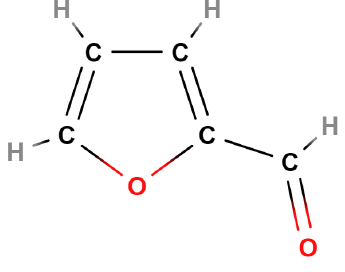
Figure 9. Structure of furfural (C 5 H 4 O 2 ).